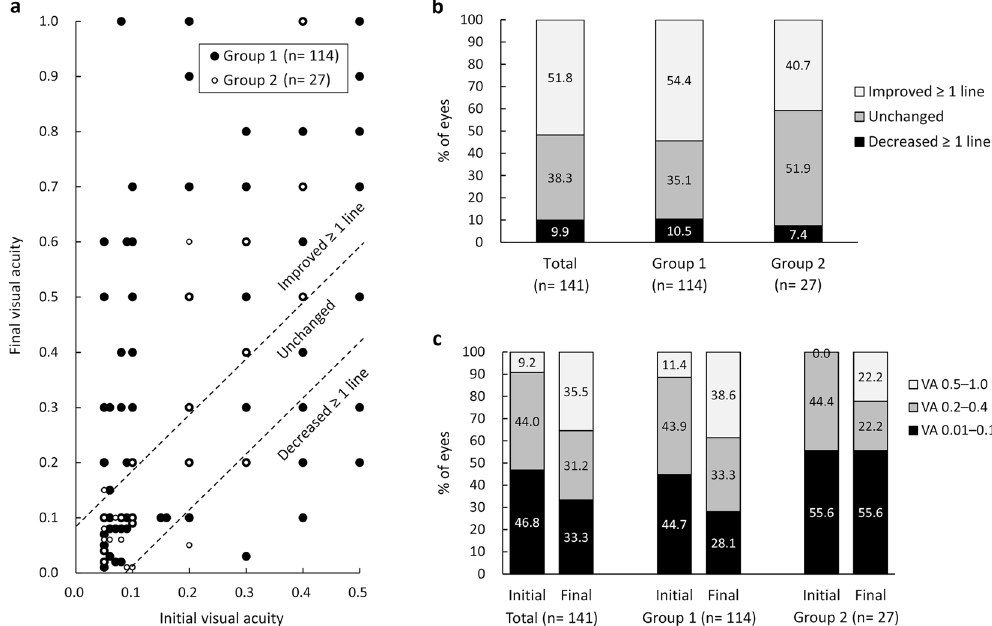
Figure 4. Initial versus final visual acuity in 141 eyes with documented visual acuity before and after treatment with ranibizumab. Group 1 comprises the eyes approved by the national health insurance system in Taiwan on only one application. Group 2 comprises the eyes approved on the second application (26 eyes) or third application (1 eye). ( a ) Scatter plot of initial versus final visual acuity. ( b ) Categorisation of visual improvement. ( c ) Categorisation of visual acuity as good (0.5–1.0), fair (0.2–0.4), and poor